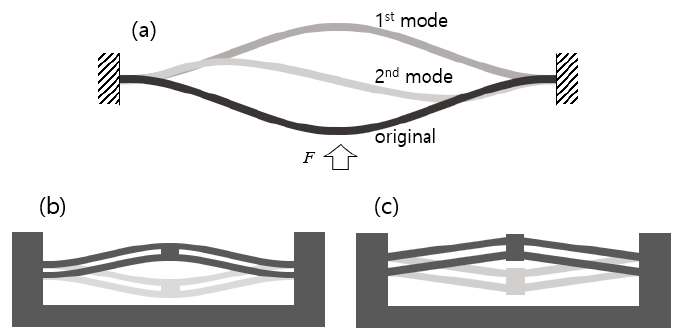
Figure 1. Compliant bistable mechanisms: ( a ) First and second post-buckling states of a pre-compressed beam; ( b ) curved parallel beams; ( c ) V-shaped parallel beams.